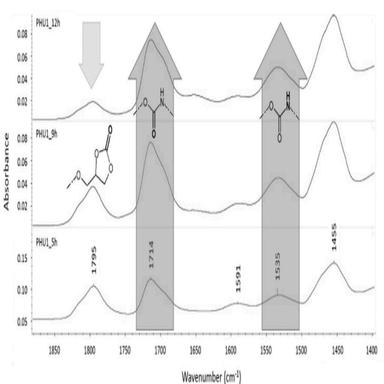
FTIR spectra of formation of PHU1 during reaction HBPG2 and JEPG 900.